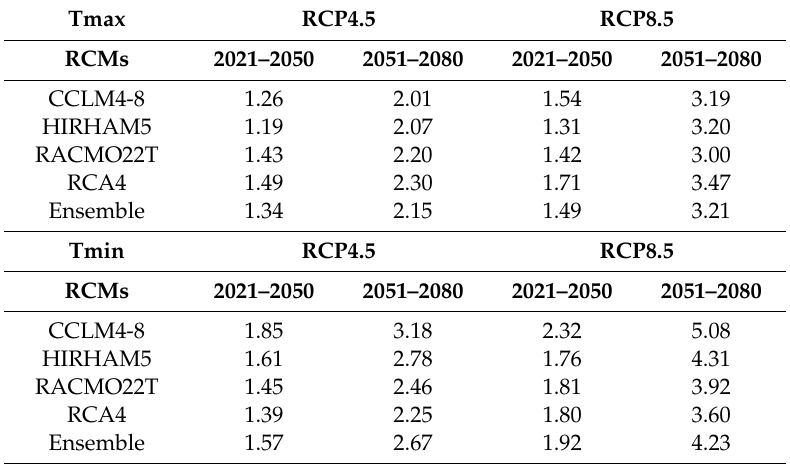
Table 5. Changes in temperature ( ◦ C) across the four RCMs in RCP4.5 and RCP8.5 scenarios. Tmax